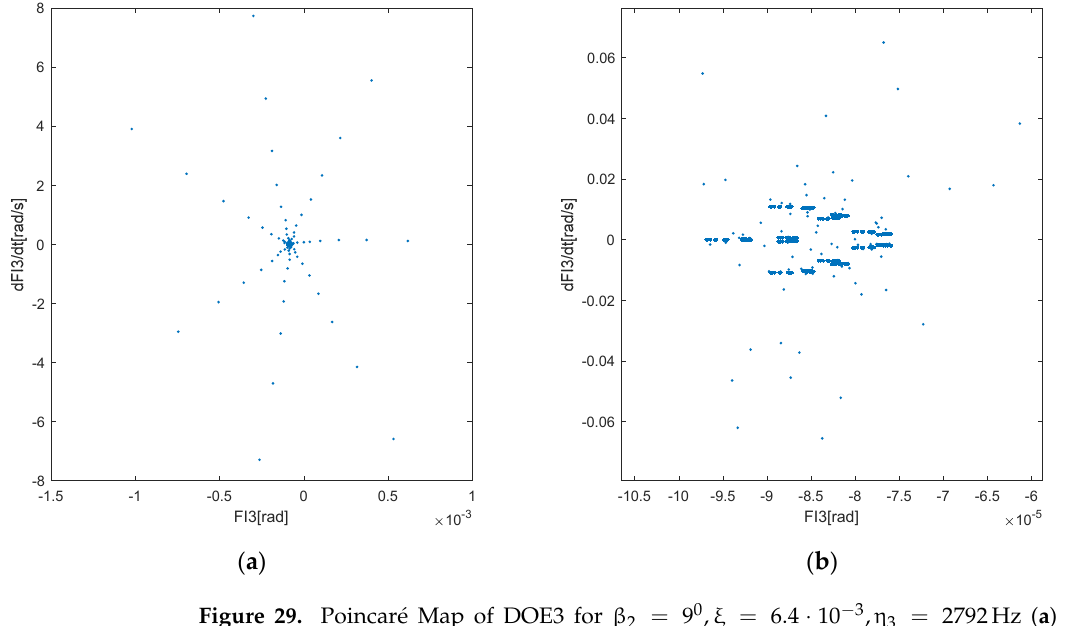
= 9 0 , ξ = 6.4 · 10 − 3 , η 2